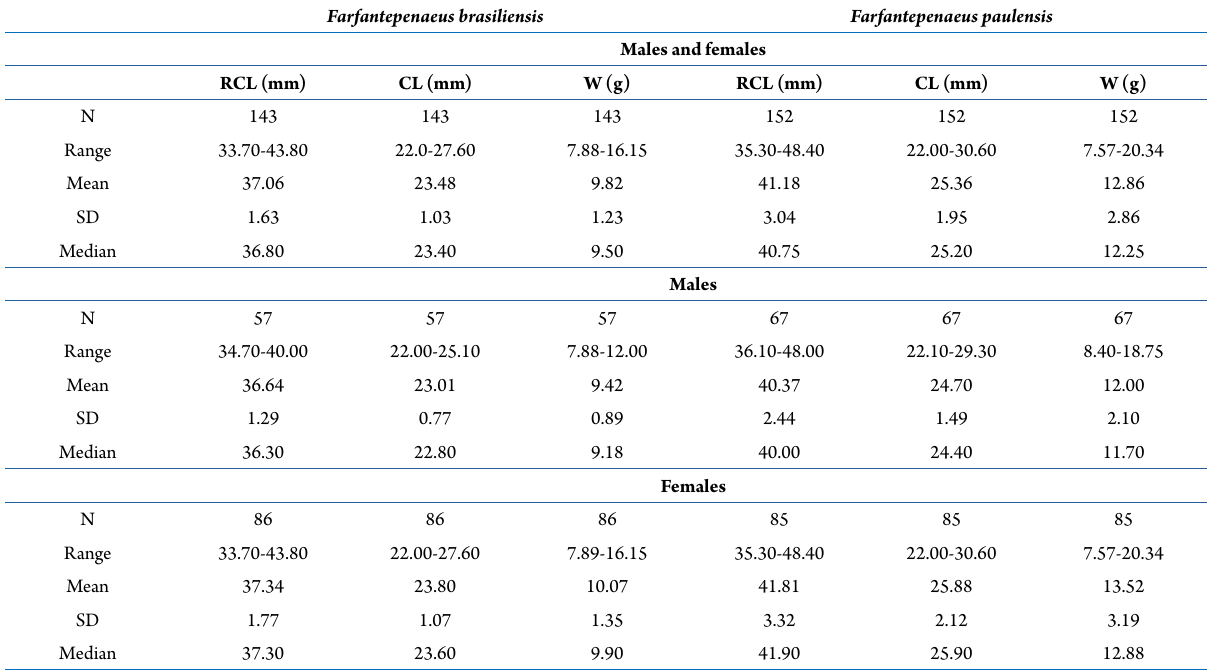
Table 3. Basic descriptive statistics of cephalothorax length (RCL, mm), carapace length (CL, mm) and individual wet weight (W, g) of females and males of Farfantepenaeus brasiliensis and F. paulensis caught in April 2019 in Rocha lagoon. (N) number of individuals, (SD) standard deviation.